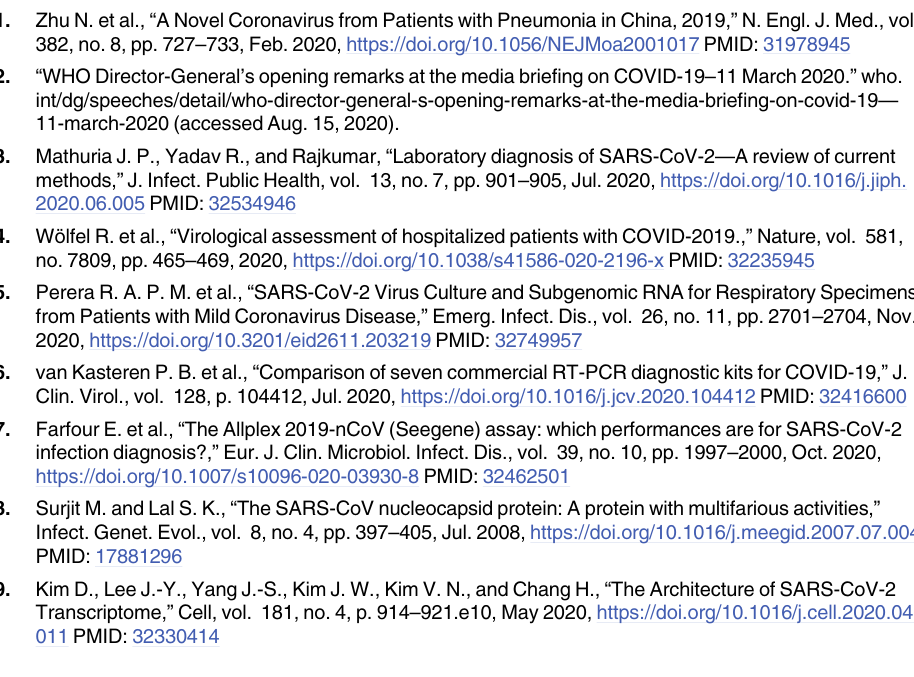
S1 Fig. Coverage of SARS-CoV-2 gene across three time-points. Coverage in all three time- points (denoted as 1,2, and 3) are shown for each SARS-CoV-2 gene, with a linear regression line denoting the decline in coverage across the time-points. The coefficient of determination (r2) and the paired t.test p.value of tp1 vs. tp3 are shown.